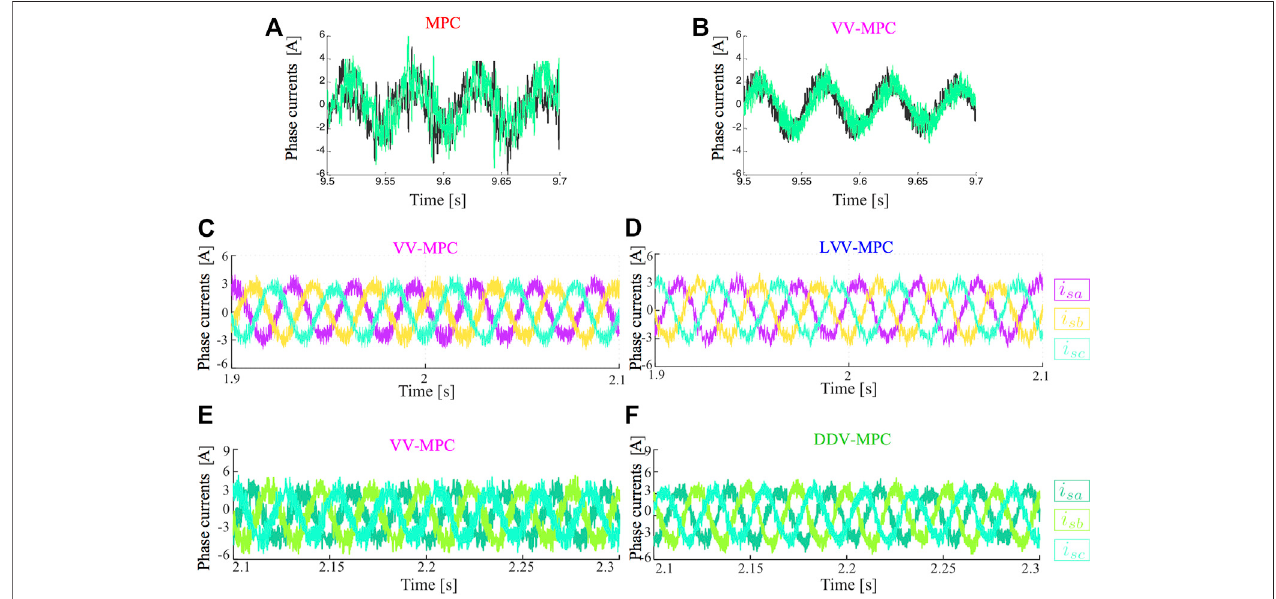
FIGURE 13 | Phase currents in an asymmetrical six-phase IM fed by a dual three-phase VSC. From top to bottom: (A) classic MPC vs. (B) VV-MPC(Gonzalez- Prieto et al., 2018), (C) VV-MPC vs. (D) LVV-MPC (Duran et al., 2021) and (E) VV-MPC vs. (F) DVV-MPC (Aciego et al., 2021).